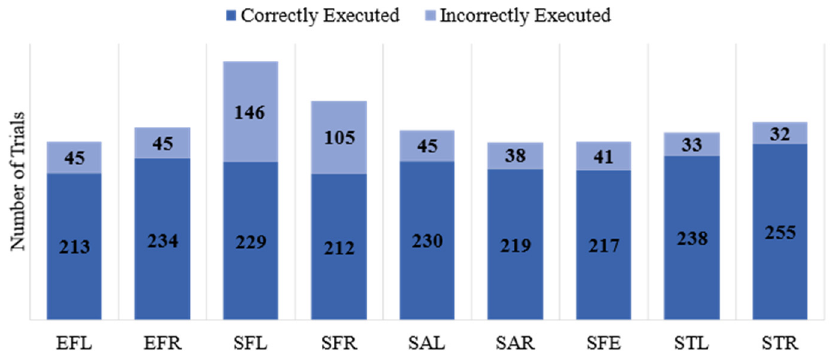
Figure 2. Number of trials for correctly and incorrectly executed exercises in the dataset.